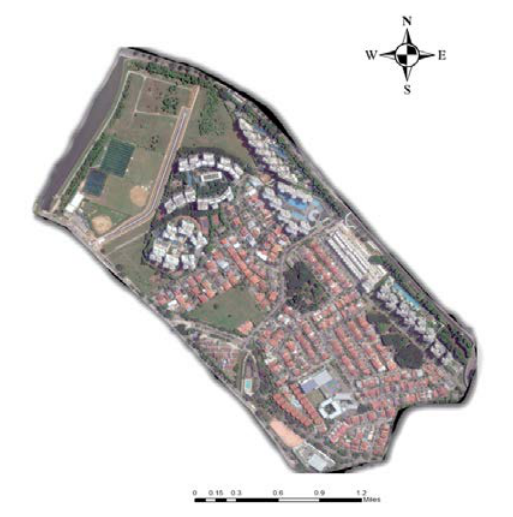
Figure 4. Rectified image of the study area West Coast, Clementi,